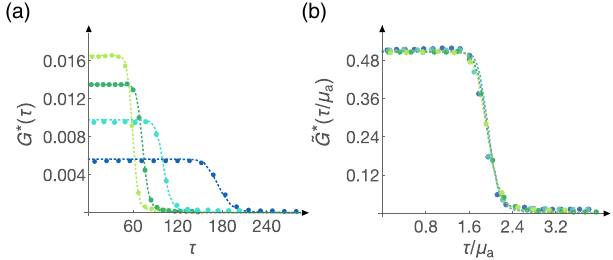
FIG. 2. Cell-age distributions, measured and predicted, from different temperatures. In (a), we show the age distributions from different temperatures (light green, 34 °C; dark green, 31 °C; cyan, 24 °C; and blue, 17 °C). The data from single-cell experi- ments are shown with circular symbols, and the predictions from the theory (with no adjustable parameters) are shown with corresponding dashed lines. In (b), we show the same age distributions as in (a), rescaled by their respective temperature- ˜ Þ ≡ μ G (cid:3) ð τ = μ G (cid:3) ð τ Þ is the mean-rescaled dependent mean ages. a a probability density of cell ages. Evidently, once mean rescaled, the probability densities undergo a scaling collapse, consistent with a single condition-specific timescale dominating stochastic growth and division statistics (see text). For the measured cell division time, distributions corresponding to these age distribu- tions; see Fig. 3B of